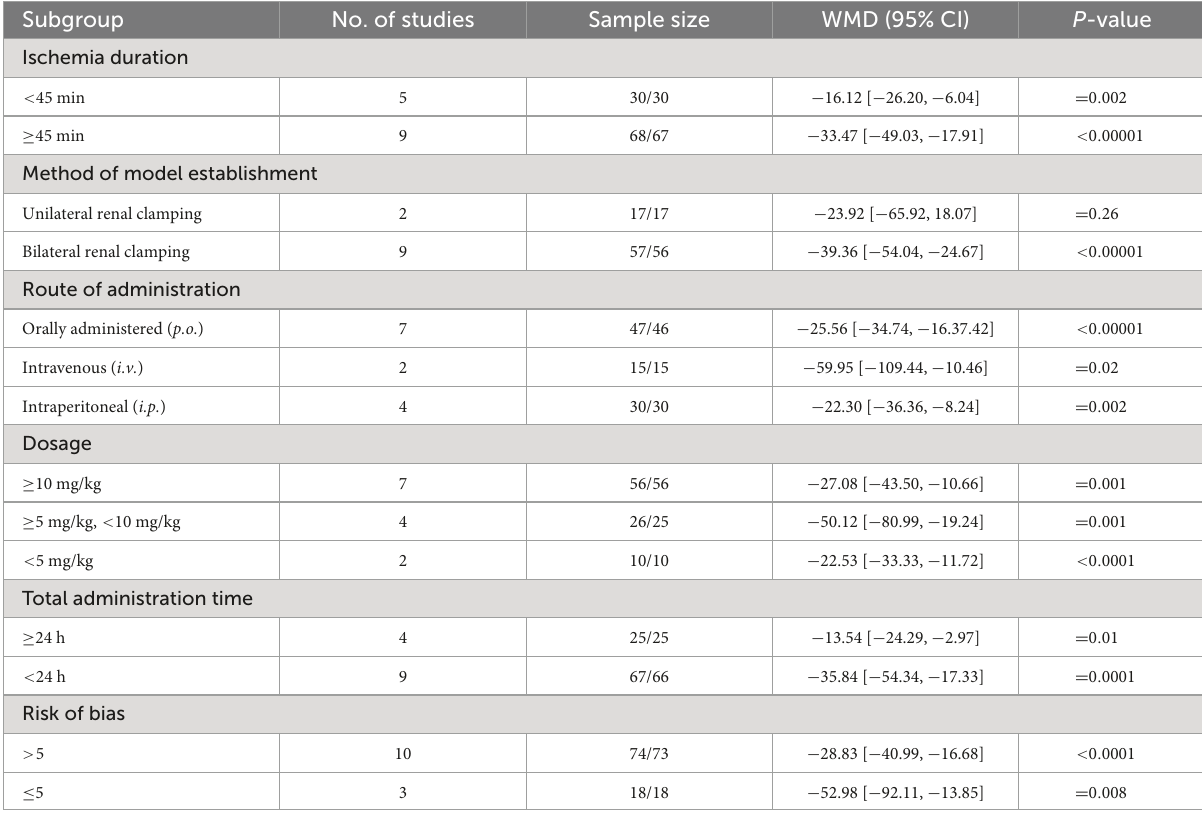
TABLE 4 Subgroup analysis of pooled estimates of BUN with different administration of RSV.